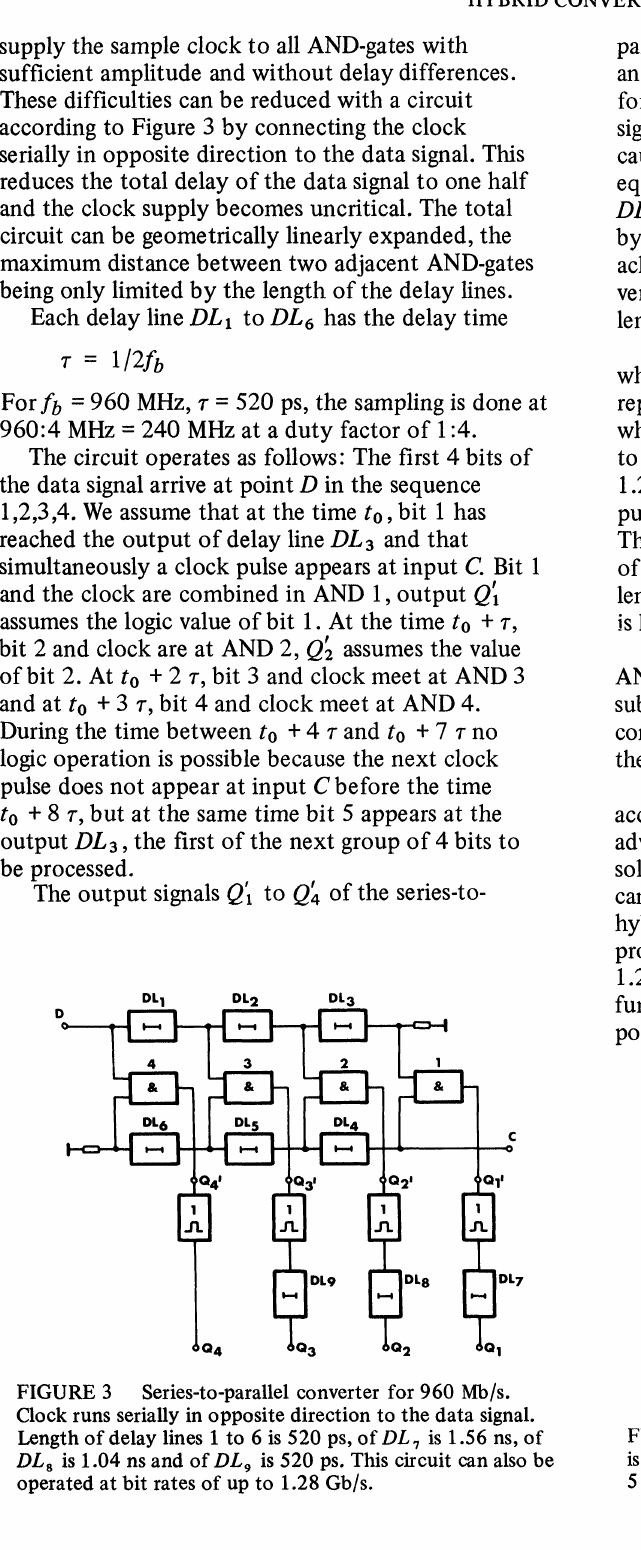
Oscillograms of Figure 3 circuit. Data signal D is sampled by dock C. Output Q’ is broadened to Q. Horiz.: 5 ns/unit, vert.: